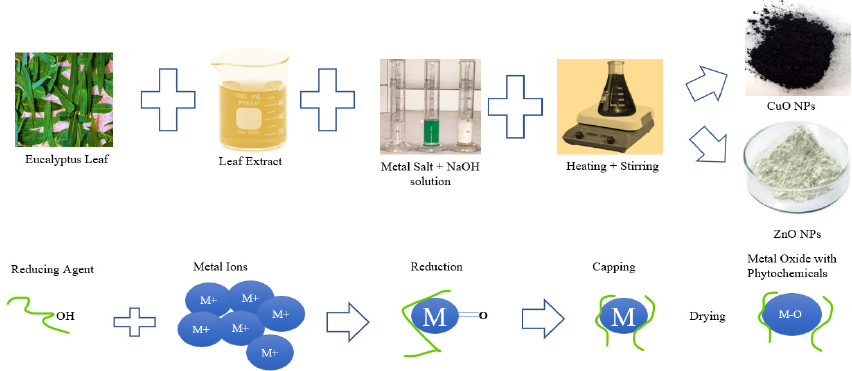
Figure 2. Nanoparticle synthesis steps.